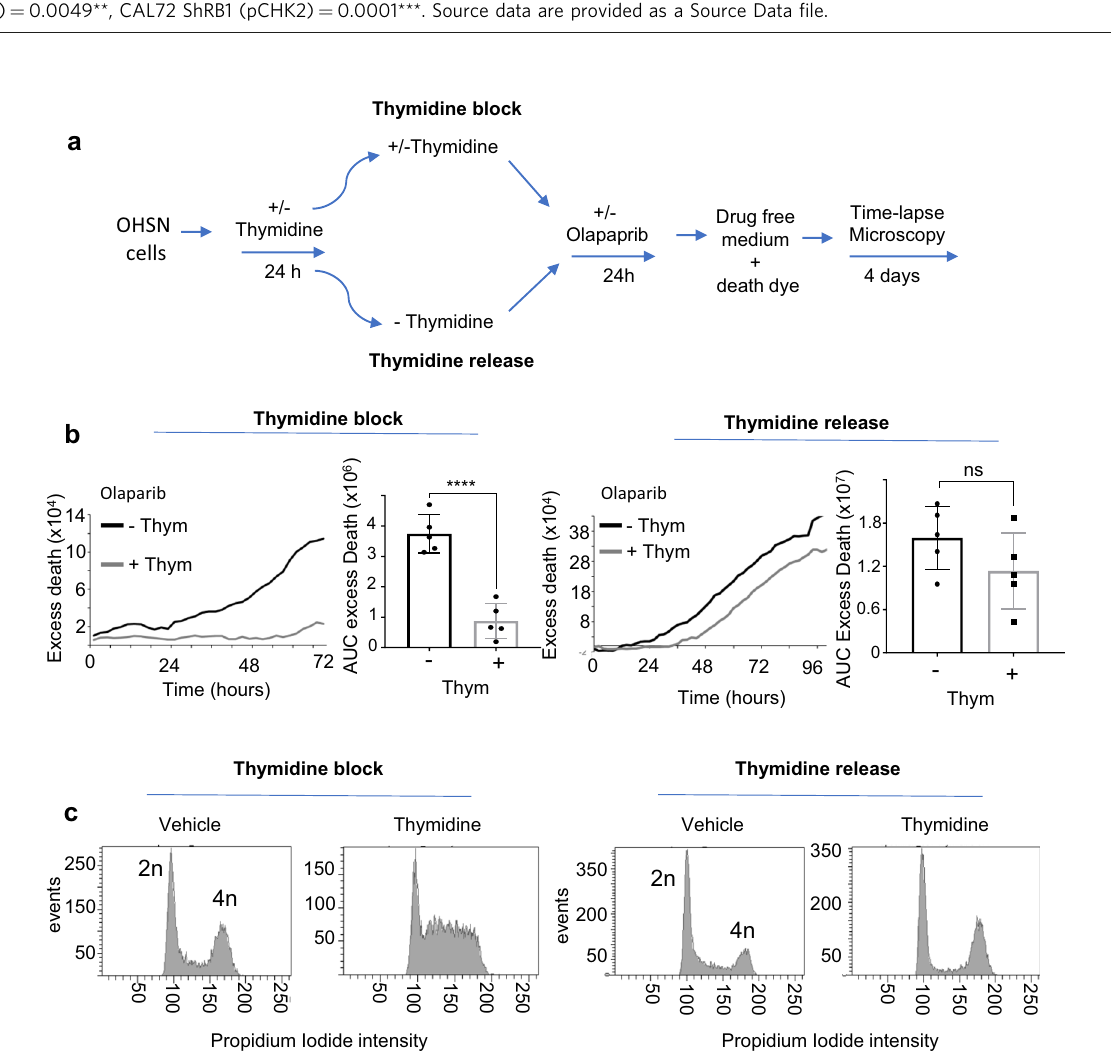
Fig. 8 DNA replication impairment rescues PARPi sensitivity. a – c PARPi sensitivity following DNA replication perturbation. a Experiment design